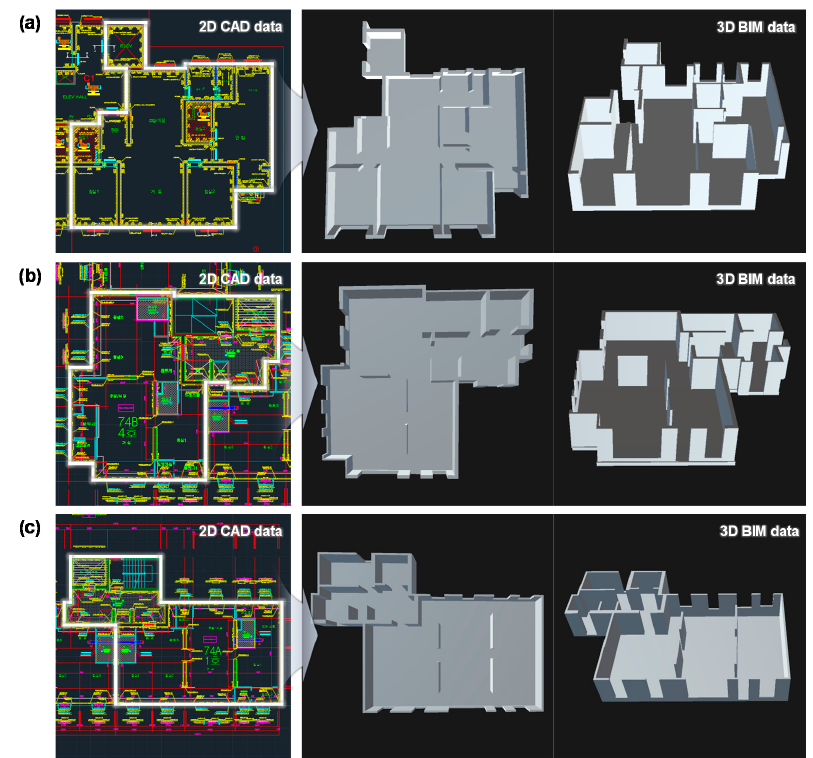
Figure 2. Two-dimensional (2D) computer-aided design (CAD) data and 3D building information modeling (BIM) data of target structures: ( a ) A, ( b ) B, and ( c ) C types.